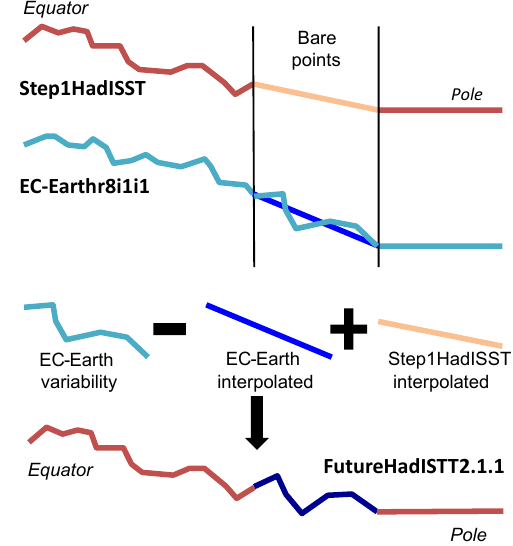
Figure 4. Scheme representing the methodology adopted to fill the “bare points”, i.e. the points where sea ice has retreated in the CMIP5 EC-Earth RCP8.5 simulation. Each line represent a SST profile from the Equator to the